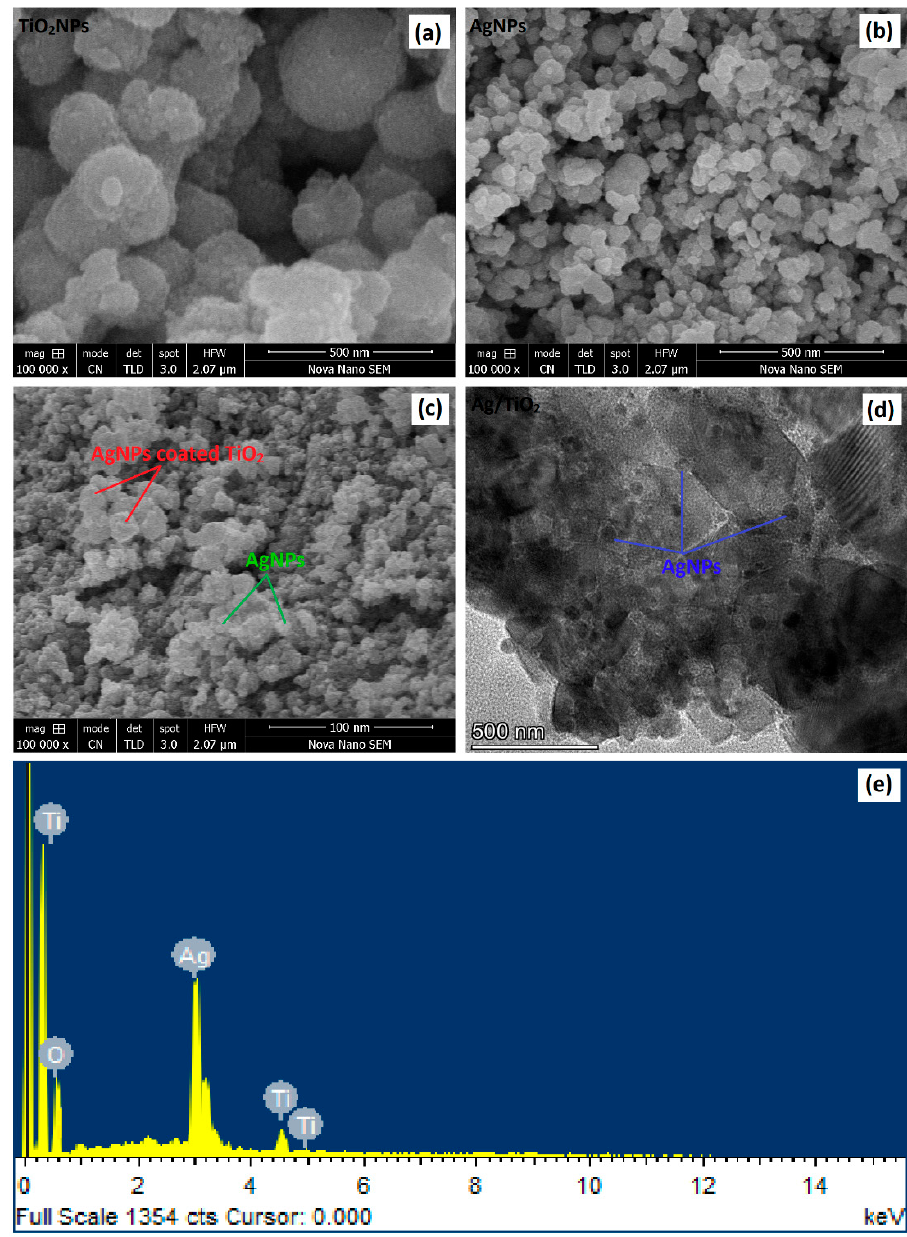
Figure 4. SEM micrograph of pure TiO 2 NPs ( a ); SEM micrograph of pure AgNPs ( b ); SEM micro- graph of Ag/TiO 2 nanocomposite ( c ); TEM micrograph of Ag/TiO 2 nanocomposite ( d ); and EDX spectrum of Ag/TiO 2 nanocomposite ( e